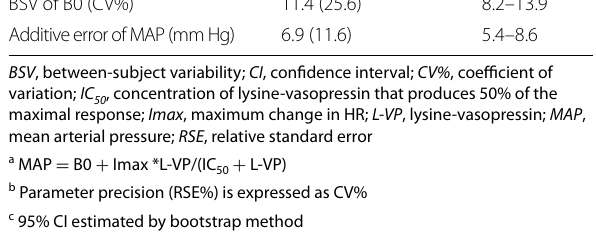
BSV , between-subject variability; CI , confidence interval; CV% , coefficient of variation; IC 50 , concentration of lysine-vasopressin that produces 50% of the maximal response; Imax , maximum change in HR; L-VP , lysine-vasopressin; MAP , mean arterial pressure; RSE , relative standard error